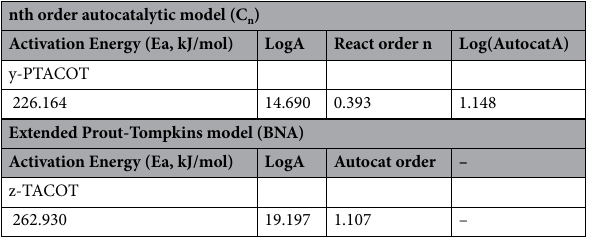
Table 2. Calculated thermal decomposition parameters of y-PTACOT and z-TACOT with mathematical